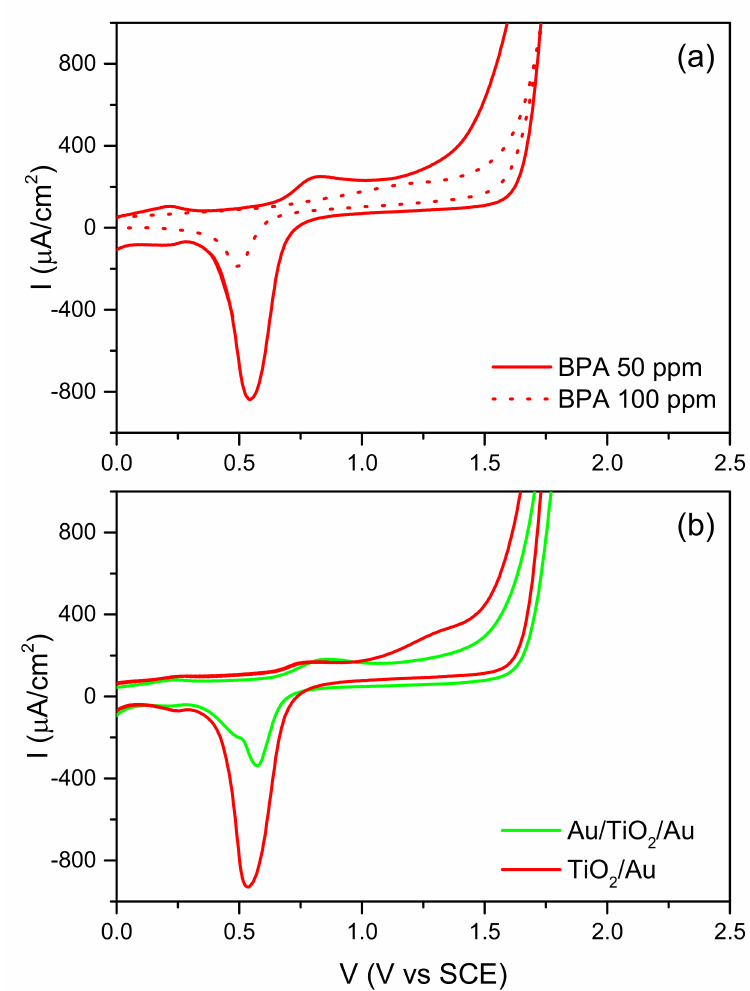
Figure 10. Comparison between the CV obtained at TiO 2 /Au sample: ( a ) in solution with two concentrations of BPA and ( b ) at samples differently M loaded, in solution with the same concentration of BPA (50